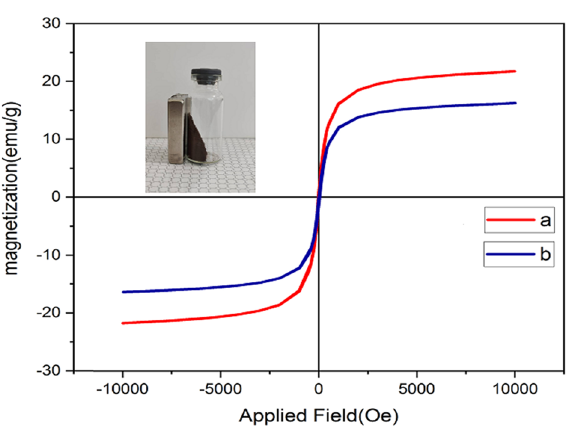
Figure 6. The VSM data for MNP–(CH 2 ) 3 Cl (curves a ) and Fe 3 O 4 @Glycerol-Cu (curves b